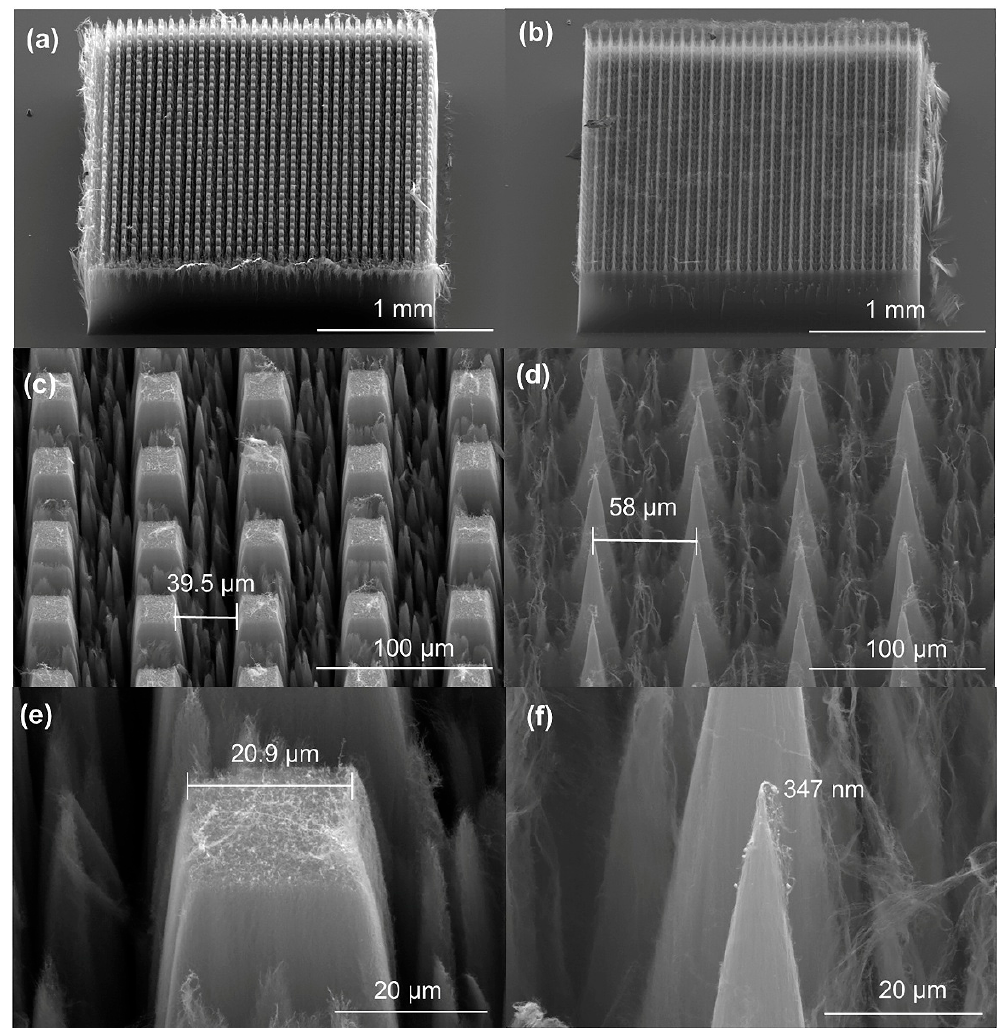
Figure 3. ( a ) A typical UV laser-processed cuboid array with a side length of about 20 μ m and ( b ) 500 nm consisting of 1089 elements. ( c ) An enlarged view of the processed array showing the formed tips of about 20 µ m and ( d ) about 500 nm. ( e ) A single tip in the array with a radius of curvature of 20.9 µ m and ( f ) 347 nm.